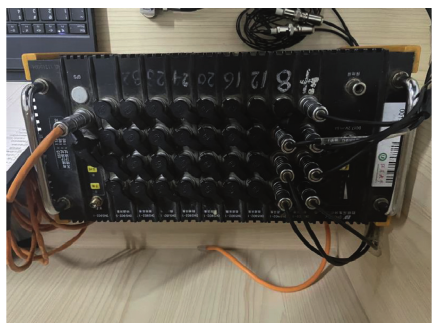
Figure 1: Signal collector.